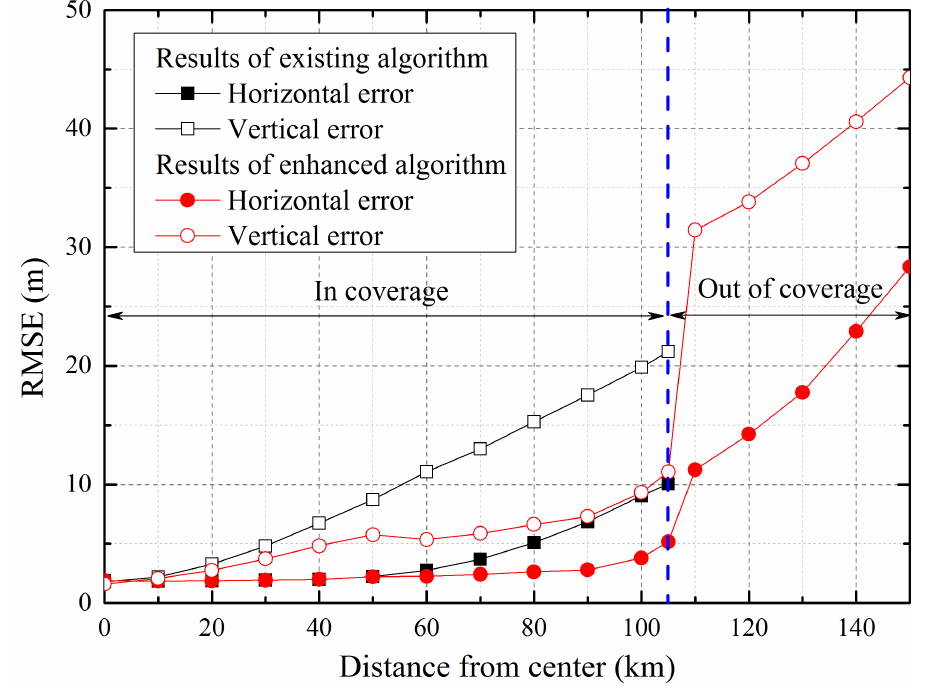
Figure 9. Horizontal and vertical accuracy according to the distance from the